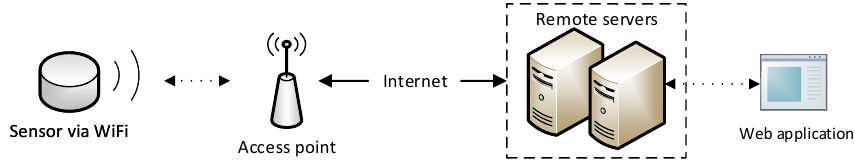
Figure 1. System Architecture from User’s